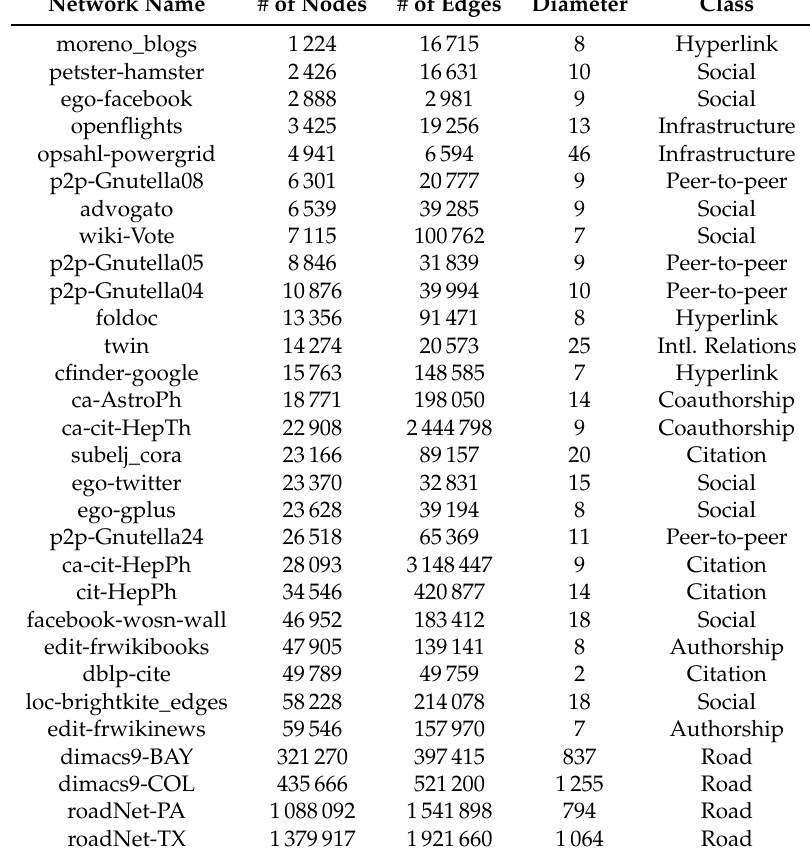
Table 1. Graphs (taken from KONECT) for our evaluation of the betweenness approximation